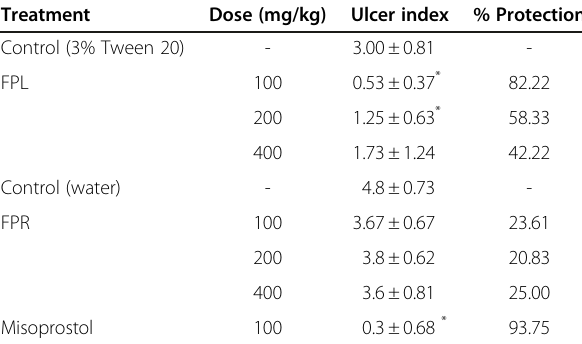
Table 1 Effect of F. paniculata leaf (FPL) and root